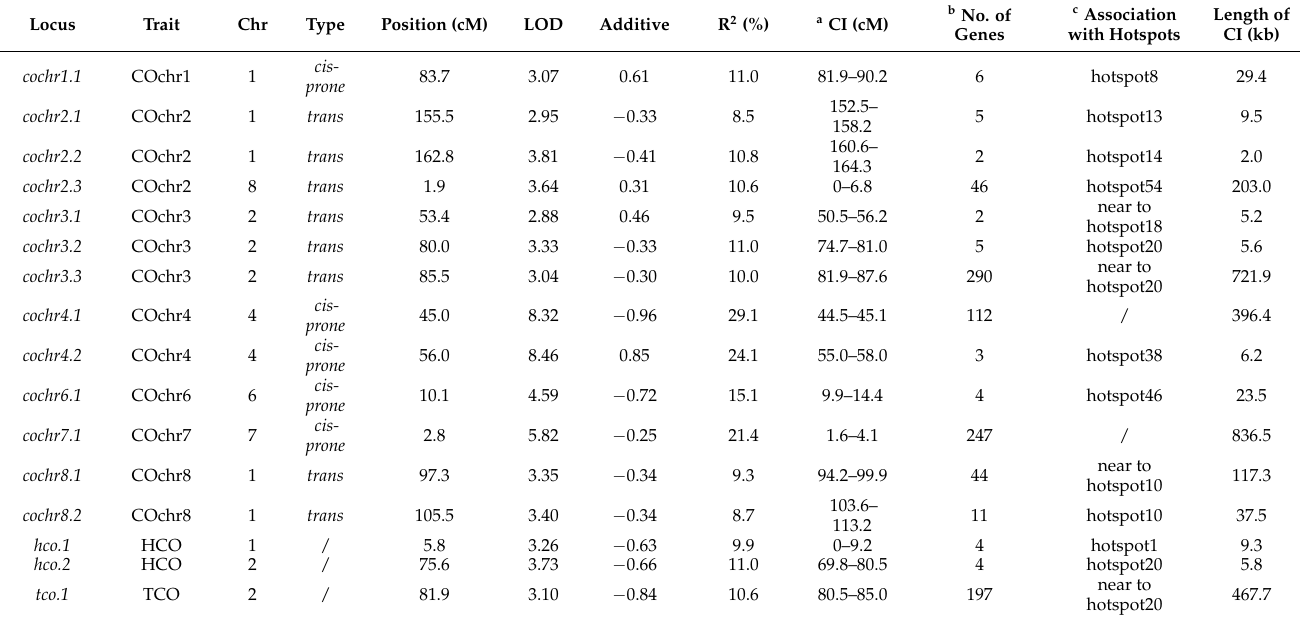
Table 1. QTLs for crossover variation of L.